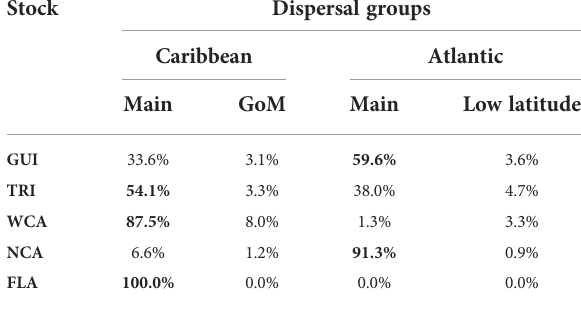
dispersal groups as a function of the stock of origin. Stock